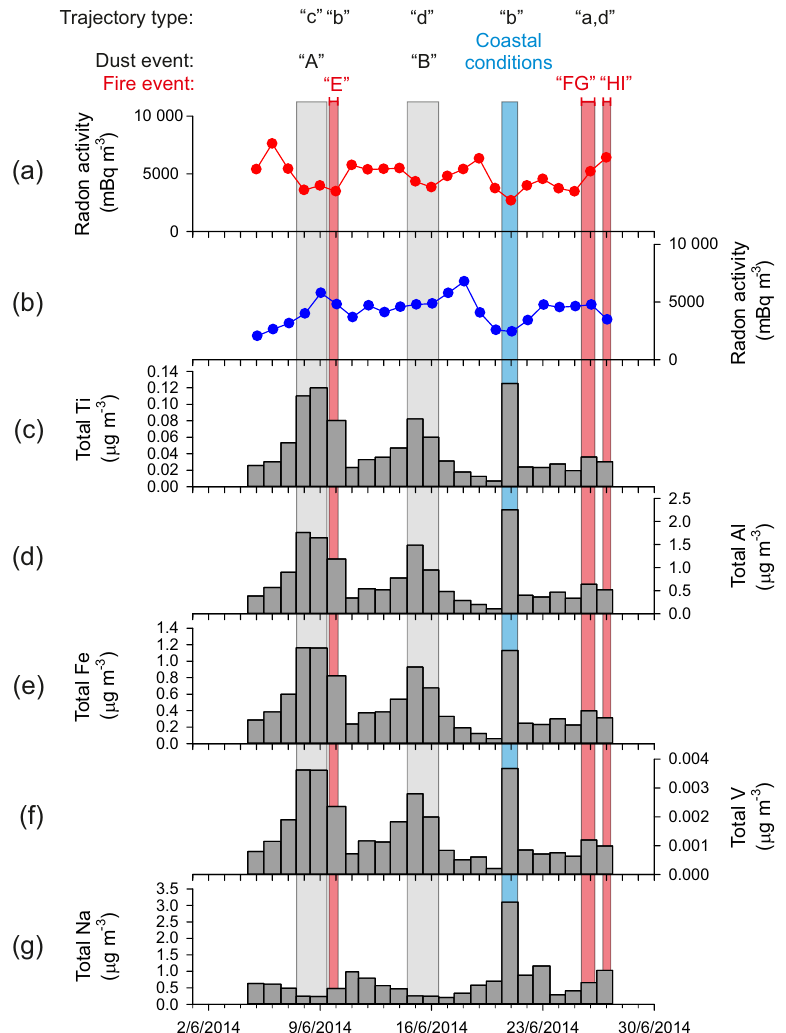
Figure 3. Composition of daily aerosol samples influenced by dry season biomass burning at Gunn Point, northern Australia. The time series highlights markers indicative of mineral dust (a) diurnal radon; (b) advective radon; and PM 10 trace element concentrations of (c) total Ti, (d) total Al, (e) total Fe, (f) total V, and (g) total Na. Fire events, dust events and coastal conditions are highlighted. For trajectory types associated with these periods refer to Fig.